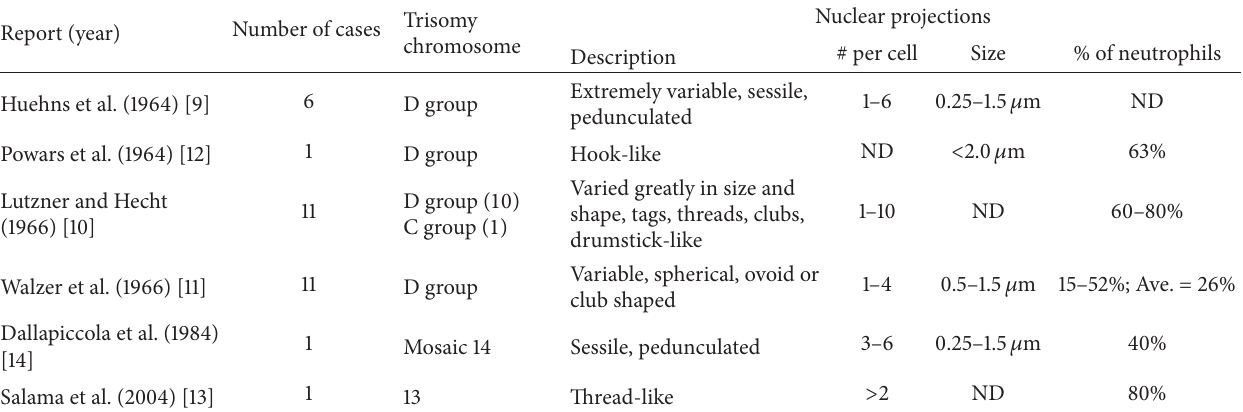
Table 1: Summary of case information in articles describing aberrant nuclear projections associated with chromosomal trisomies. Report